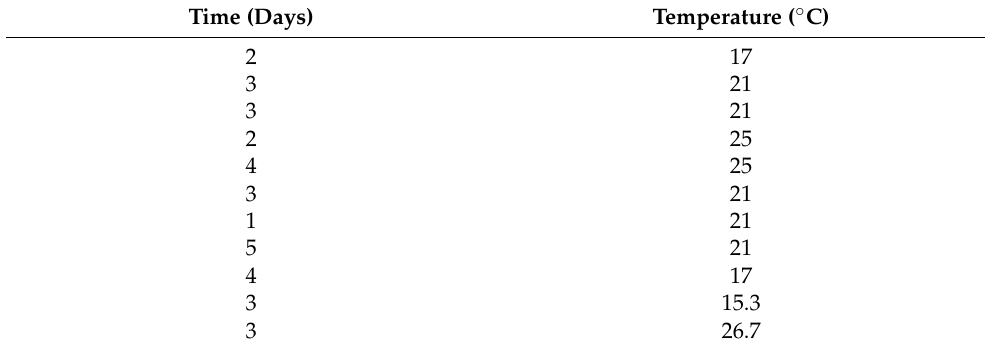
Table 1. Central Composite Design (CCD) obtained by RSM, with two independent variables (time (t) in days and temperature (T) in ◦ C), three center points and two-star points. The design was replicated. Time